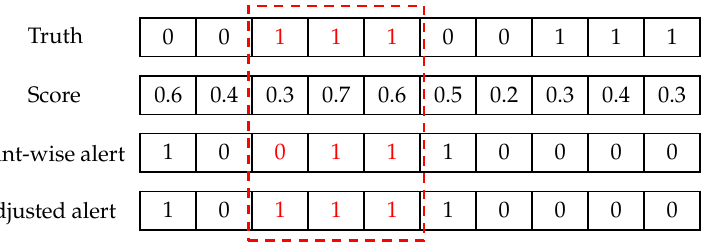
Figure 7. Illustration of adjusted F 1 with a threshold of